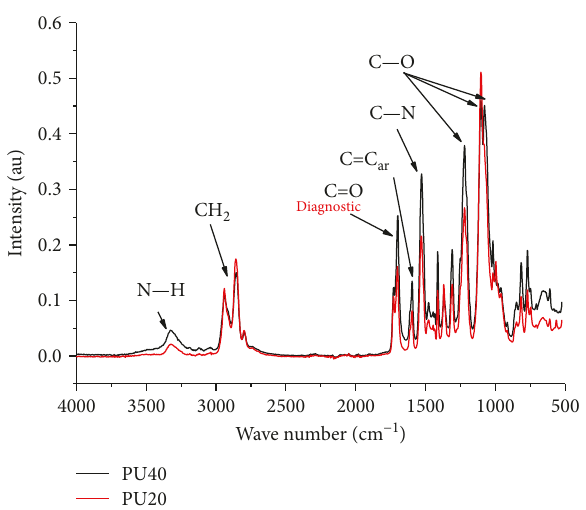
Figure 3: FTIR spectra for nonmodi fi ed PU with di ff erent hard segment ratios.